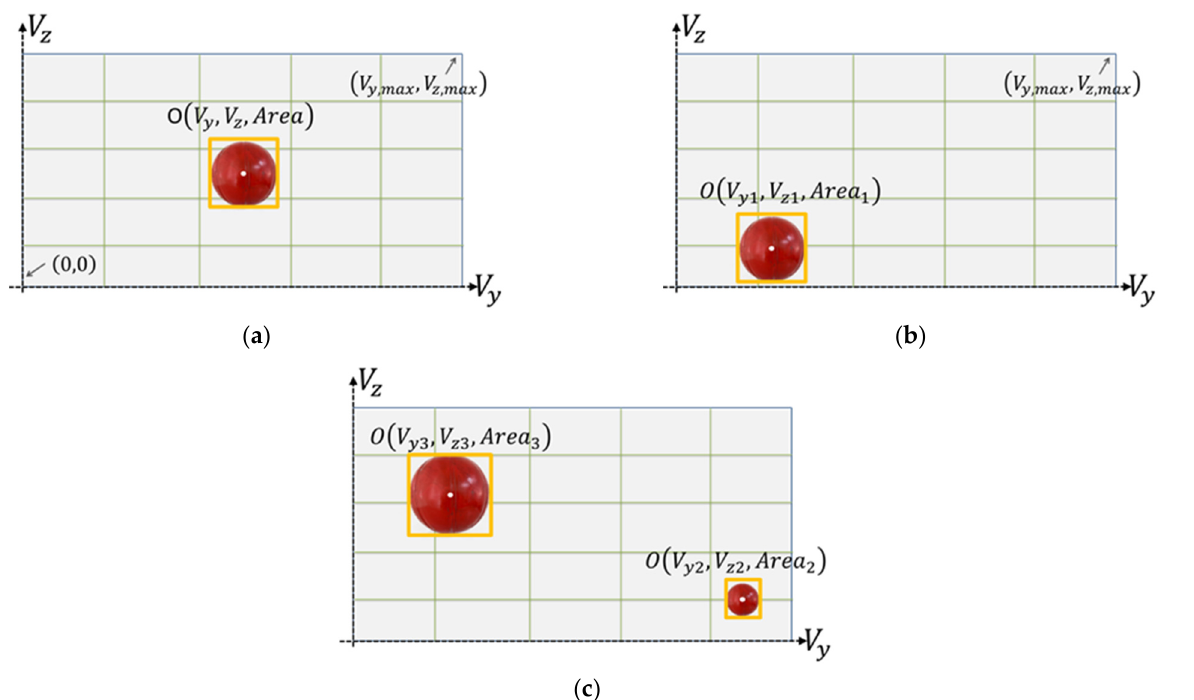
Figure 6. Definitions of the tracking control parameters values: ( a ) the benchmark, ( b ) the orientations, and ( c ) the